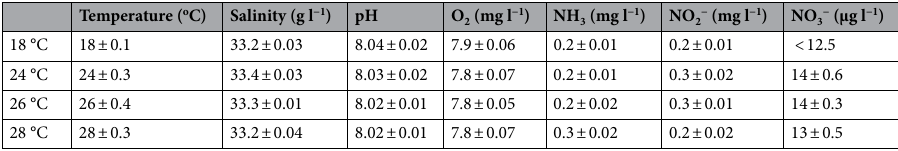
Table 1. Mean values of sea water parameters. Sea water parameters as measured in all experimental conditions. Values are presented as means ± SD (n = 10).